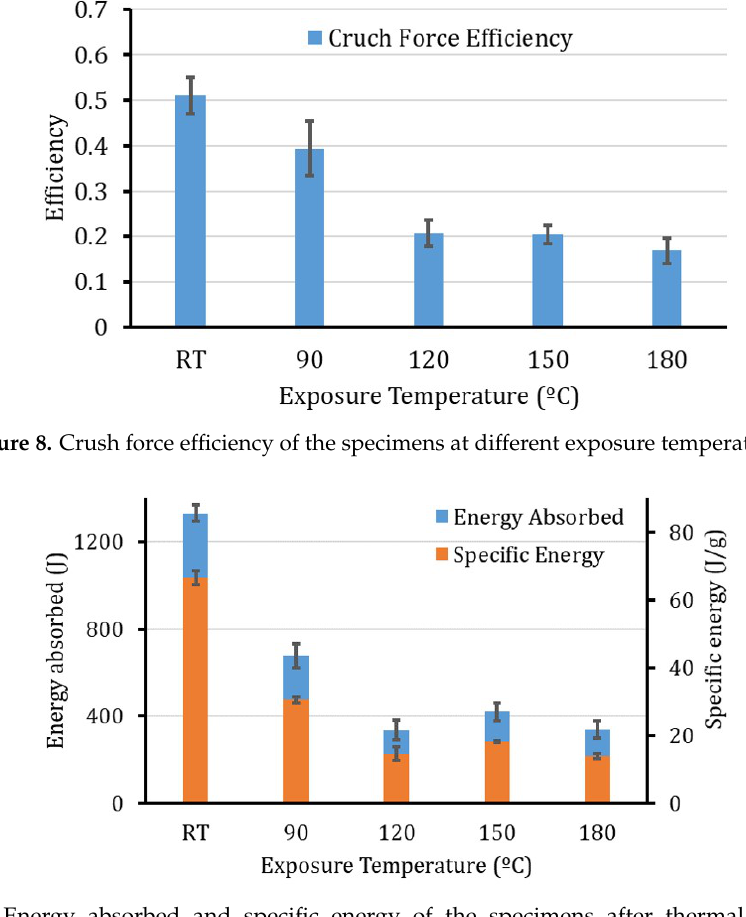
Figure 9. Energy absorbed and specific energy of the specimens after thermal exposure to different